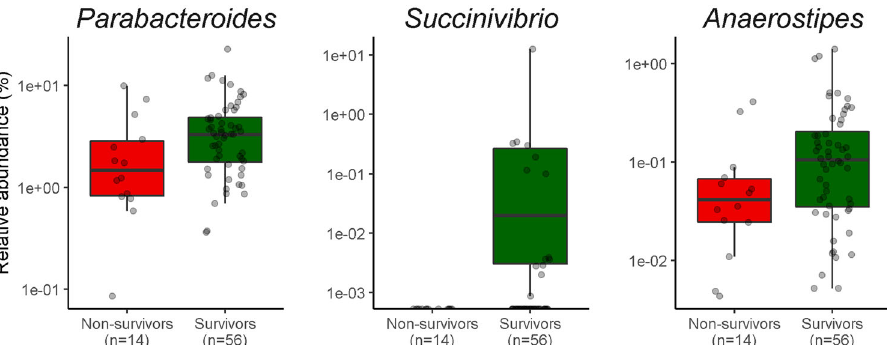
Fig. 5 Relative abundance of the gut microbiota at the genus level between nonsurvivors and survivors after matching. Parabacteroides , Succinivibrio , and Anaerostipes were enriched in survivors compared with nonsurvivors. P < 0.05 using the Mann – Whitney U